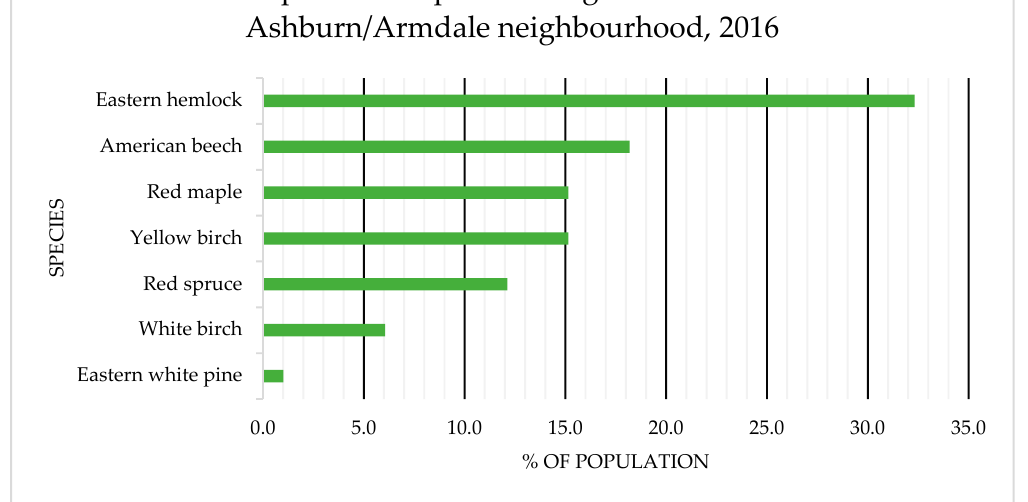
Figure 7. Species distribution in the Ashburn/Armdale neighborhood (adapted from source data: 11). Large proportions of the longest-lived, foundational species of the Acadian forest, such as Eastern hemlock, American beech, and Red spruce, suggest that ecological integrity of naturalized forest patches may be higher than those patches found on golf courses. Forests 2020 , 11 , x FOR PEER REVIEW